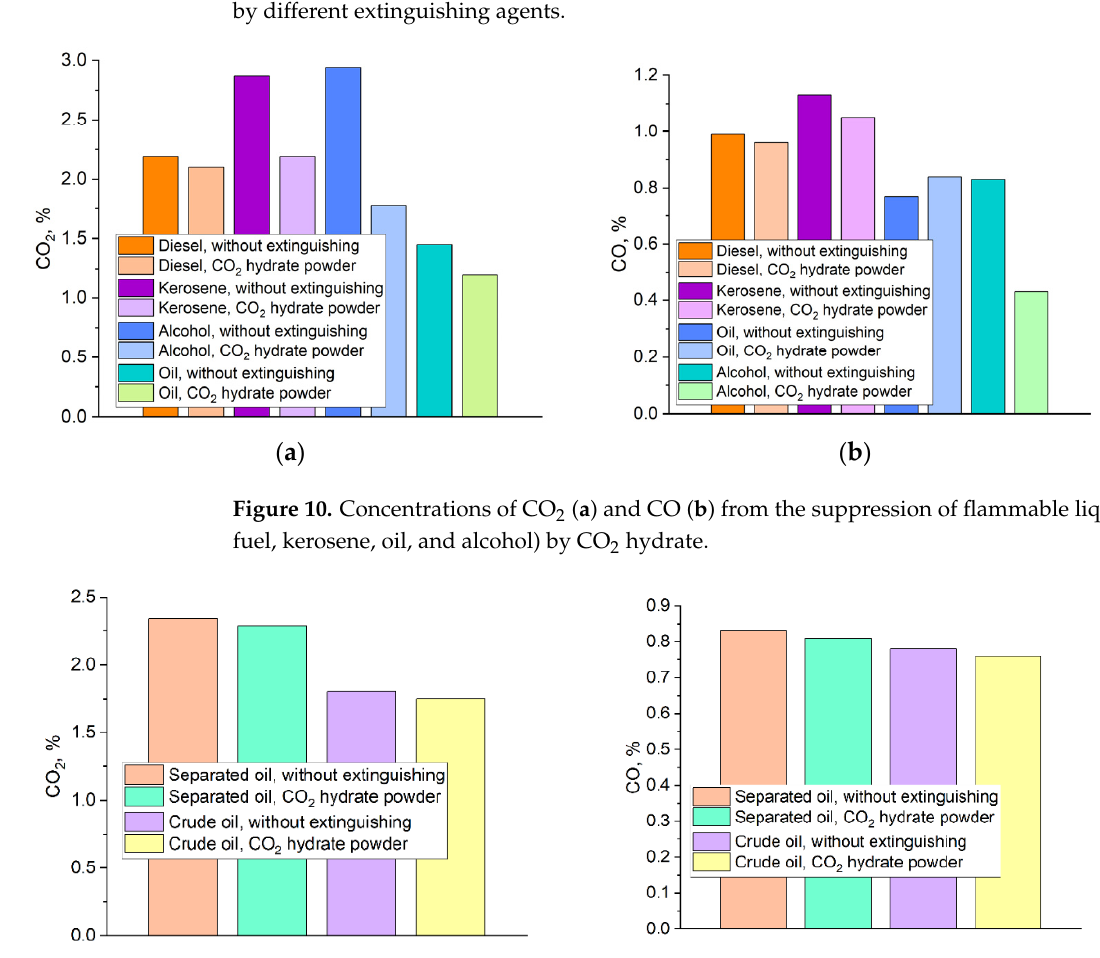
( b ) Figure 11. Concentrations of CO 2 ( a ) and CO ( b ) released during the suppression of crude and sep- arated oil fire by CO 2 hydrate. Figure 12 shows the temperature trends illustrating the flame temperature variation dynamics (AI-92 gasoline) without extinguishing and when using CO 2 hydrate powder ( m g = 0.6–2 g). The flame temperature was measured by chromel-alumel thermocouples. The thermocouple junctions (Figure 12) were located at different distances from the flam- mable liquid surface: T#1—10 mm; T#2—30 mm; T#3—50 mm. We used the following notations in Figure 12: t b is the fire extinction time; t* is the moment of the extinguishing agent supply; t e is the time from ignition to extinction. According to Figure 12, when fire suppression is not provided, a short-term temperature decrease (down to 70–300 °C) is observed at the beginning of the experiment when an extinguishing agent is supplied;